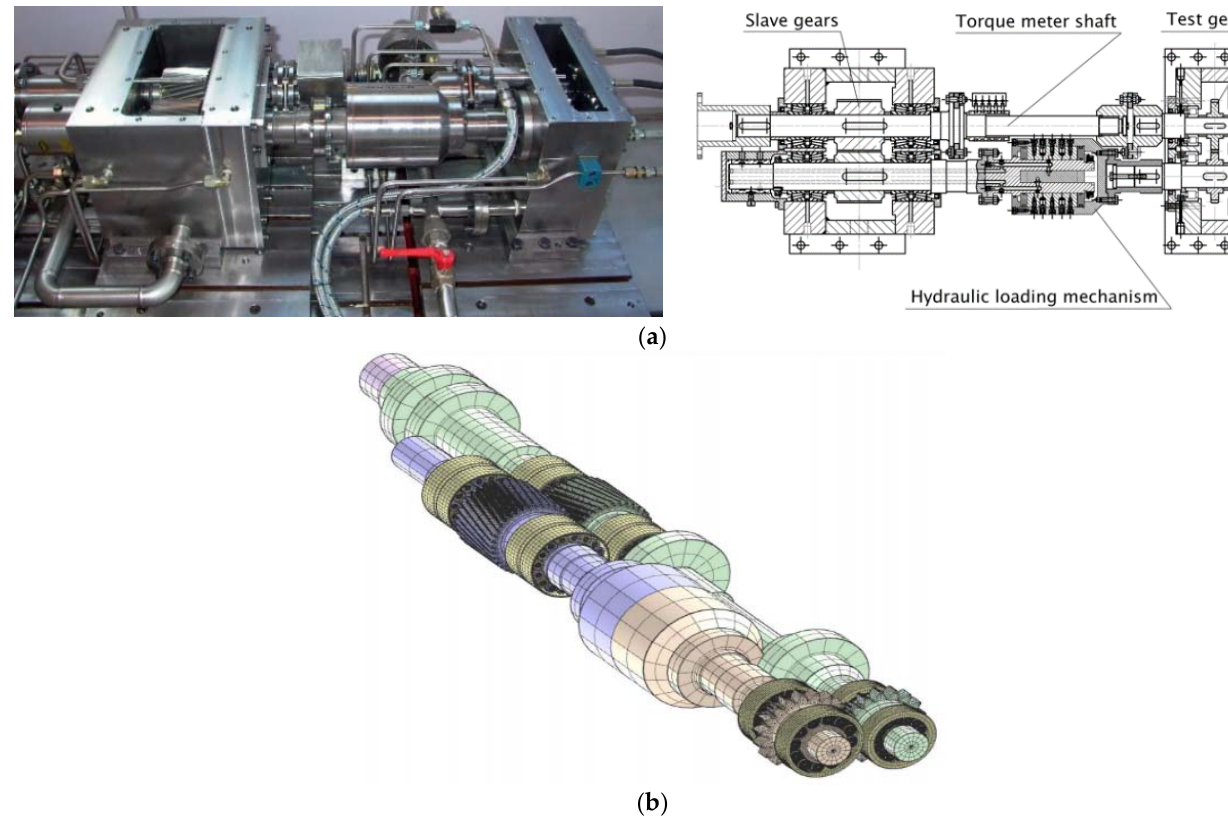
Figure 3. ( a ) Layout of the back-to-back system; ( b ) numerical model.